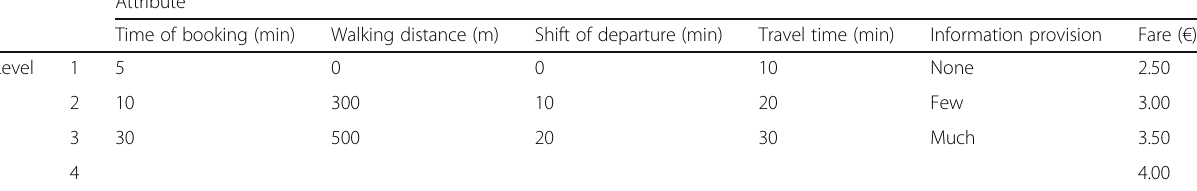
Table 2 Final attributes and corresponding levels used for DCE Attribute